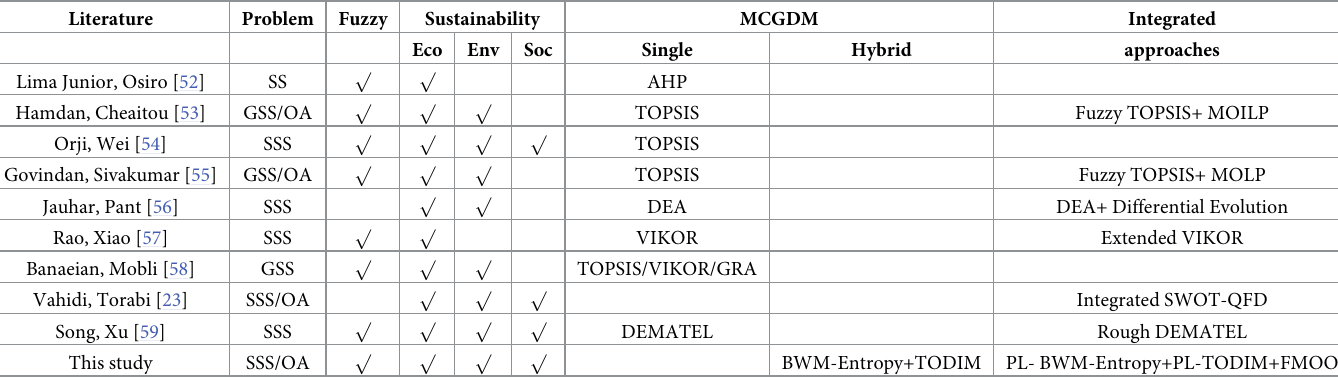
Table 2. Comparison of studies sustainable criteria and approaches.